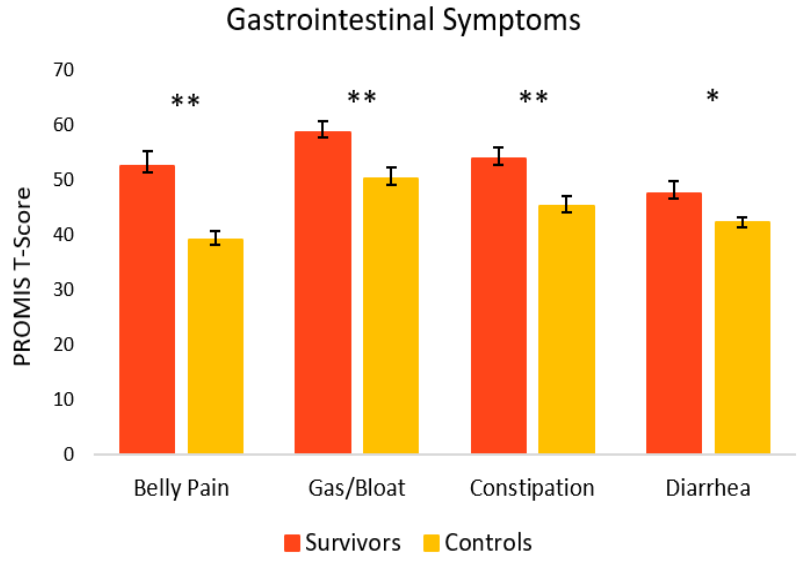
Figure 3. Gastrointestinal symptoms in cancer survivors and healthy controls. Group means are presented. Error bars represent standard error of the mean (SEM). Significance is denoted by ** at the p < 0.01 level, and * at the p < 0.05 level. Group n = 13–18.